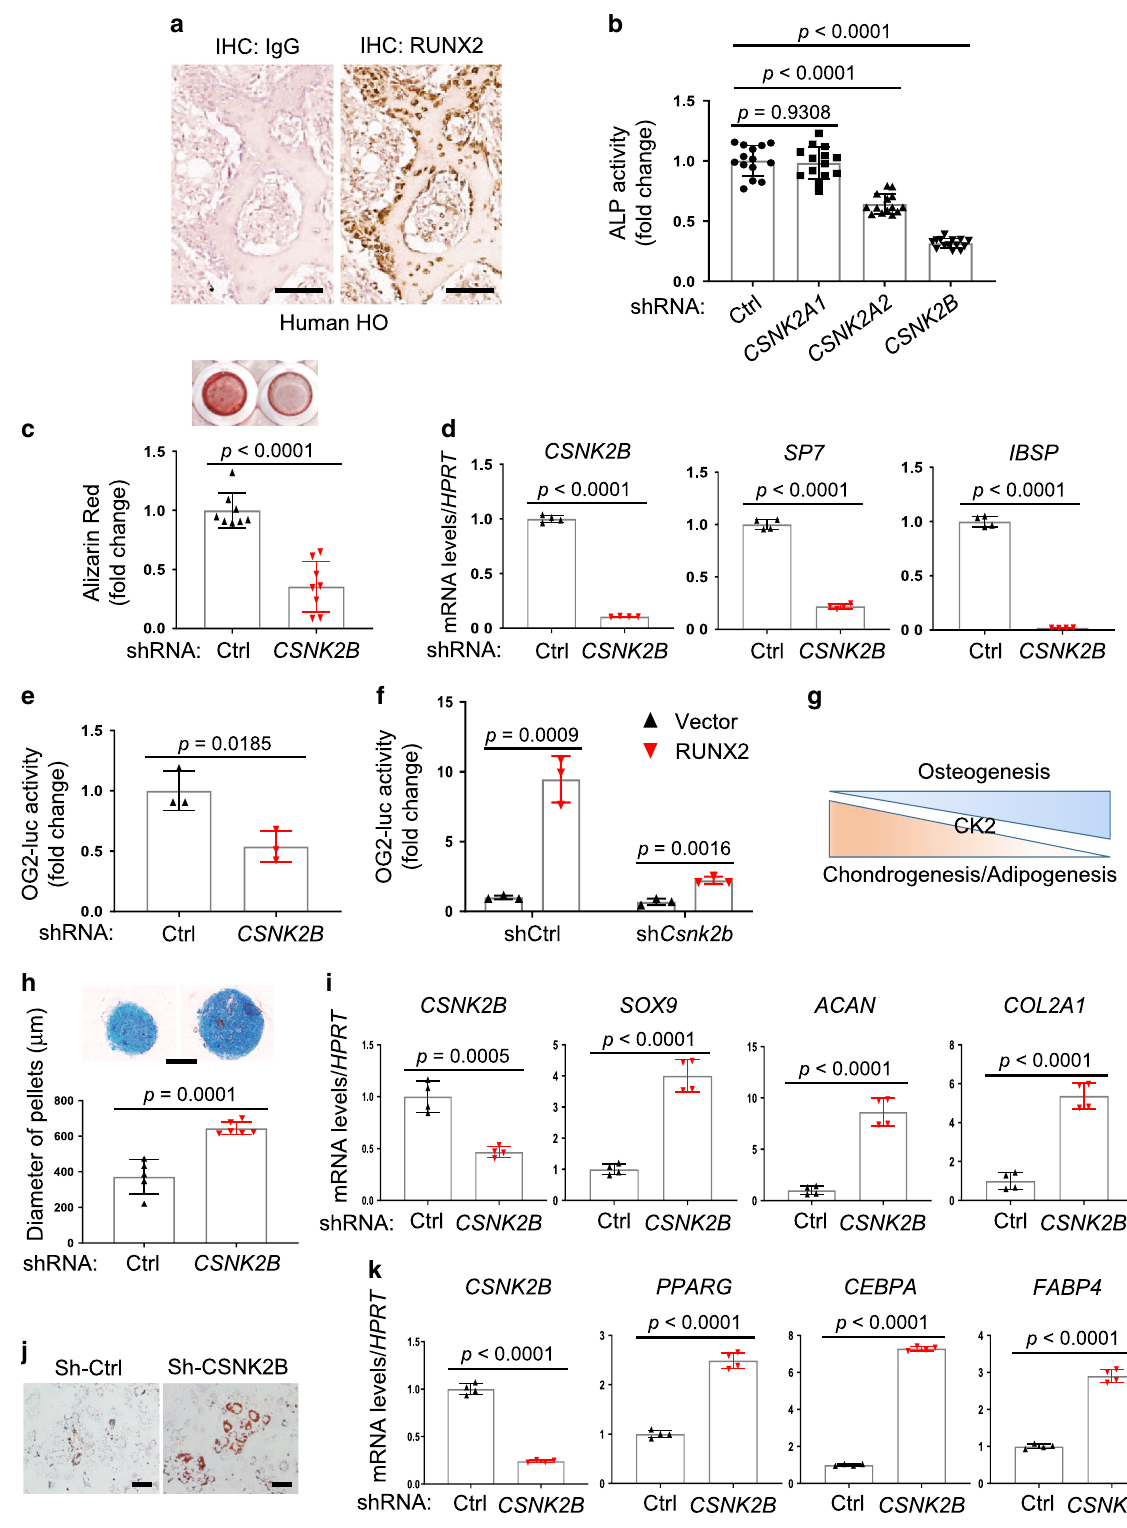
top). Likewise, endochondral ossi fi cation of long bones was arrested at the earliest stages of primary ossi fi cation center for- mation (Fig. 2d, e and Supplementary Fig. 5g, h). These skeletal phenotypes are similar to those seen in Runx2 Prx1 pups 5 , sug- gesting that CK2 is required for RUNX2 regulation. Skeletal development occurs through a hierarchy of bone lineage-speci fi c progenitors, and these progenitors can be